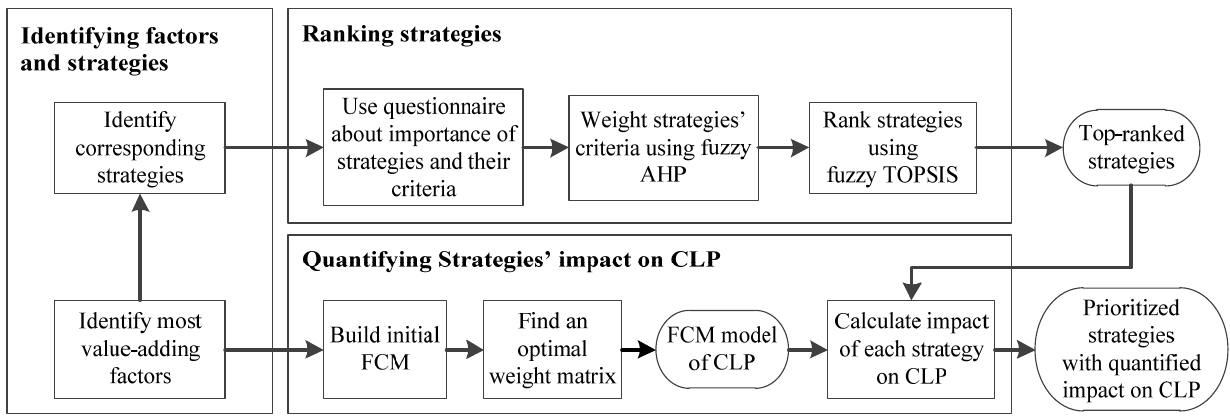
Figure 1. Proposed framework to rank improvement strategies and quantify their impact on CLP.